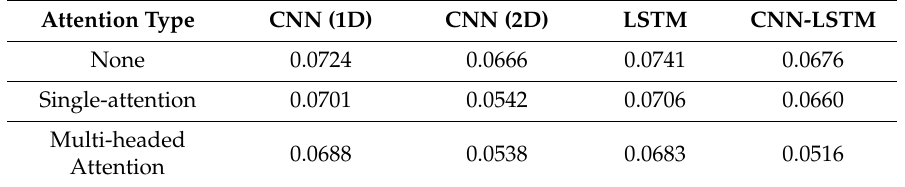
Table 5. E ff ect of various attention mechanisms on di ff erent neural network architectures (MSE). Attention